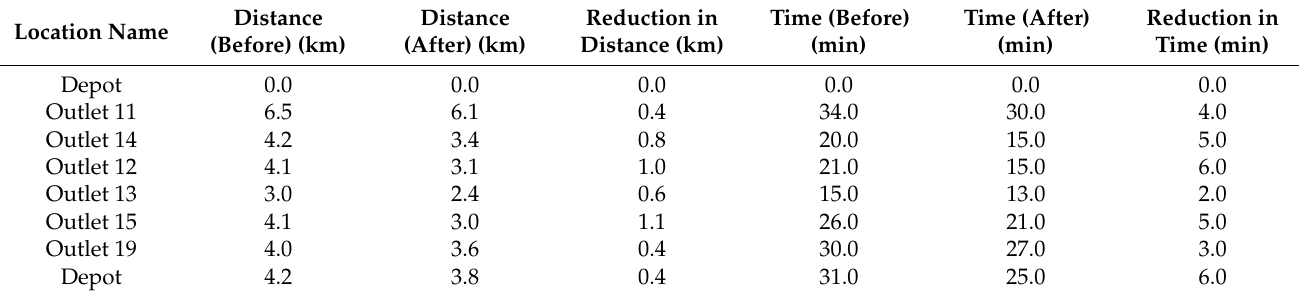
Table 6. Traveling distance before and after using the Intelligent Route Optimizer application for vehicle